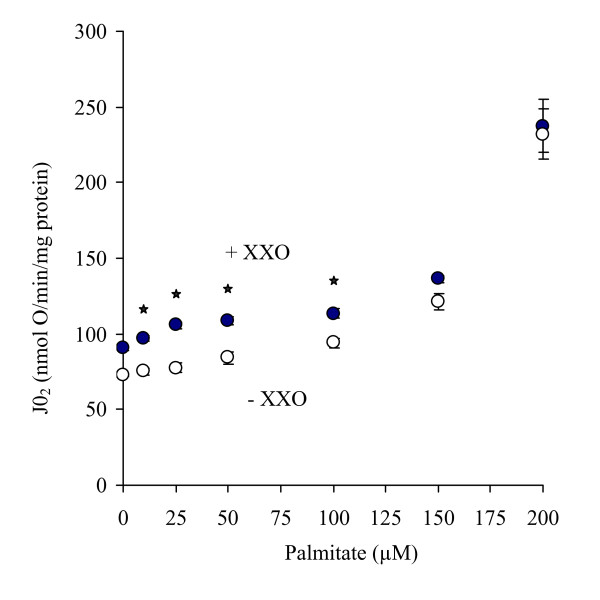
Effect of increasing doses of palmitate on non-phosphorylating respiration of skeletal muscle mitochondria from T3-treated ducklings in the presence (dark circles) or absence (open circles) of xanthine/xanthine oxidase (XXO). Mitochondria were isolated from T3-treated ducklings and respiration was initiated with 5 mM succinate in the presence of 0.3% FAF-BSA. Values are means ± SEM from 5-6 determinations. * indicates a significant (P < 0.05) interaction between the dose of palmitate and the addition of XXO implying a higher stimulation of XXO at a given palmitate concentration.